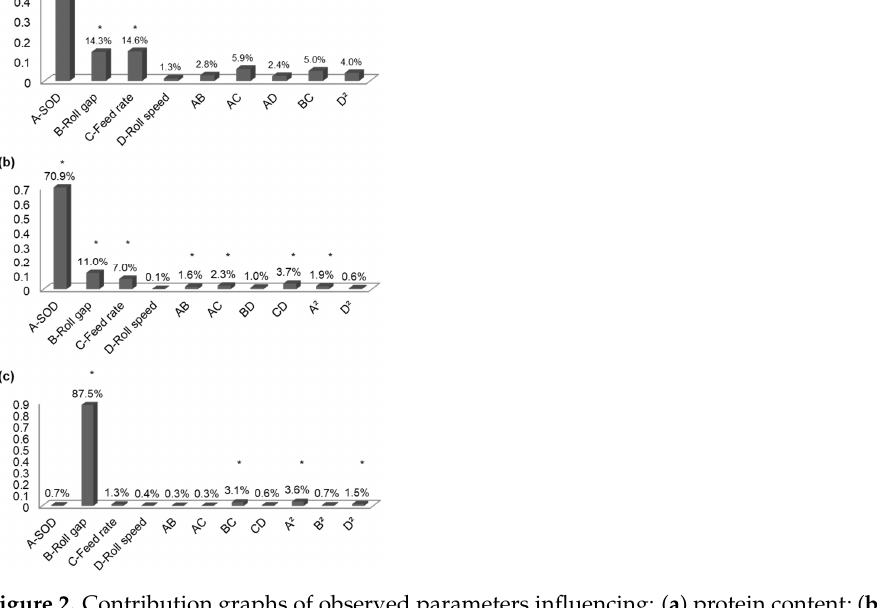
Figure 2. Contribution graphs of observed parameters influencing: ( a ) protein content; ( b ) fraction yield; and ( c ) grinding energy consumption. By star are denoted input factors, their interactions oe quadratic terms which expressed statistically significant (<0.05) influence (according to ANOVA table) on observed